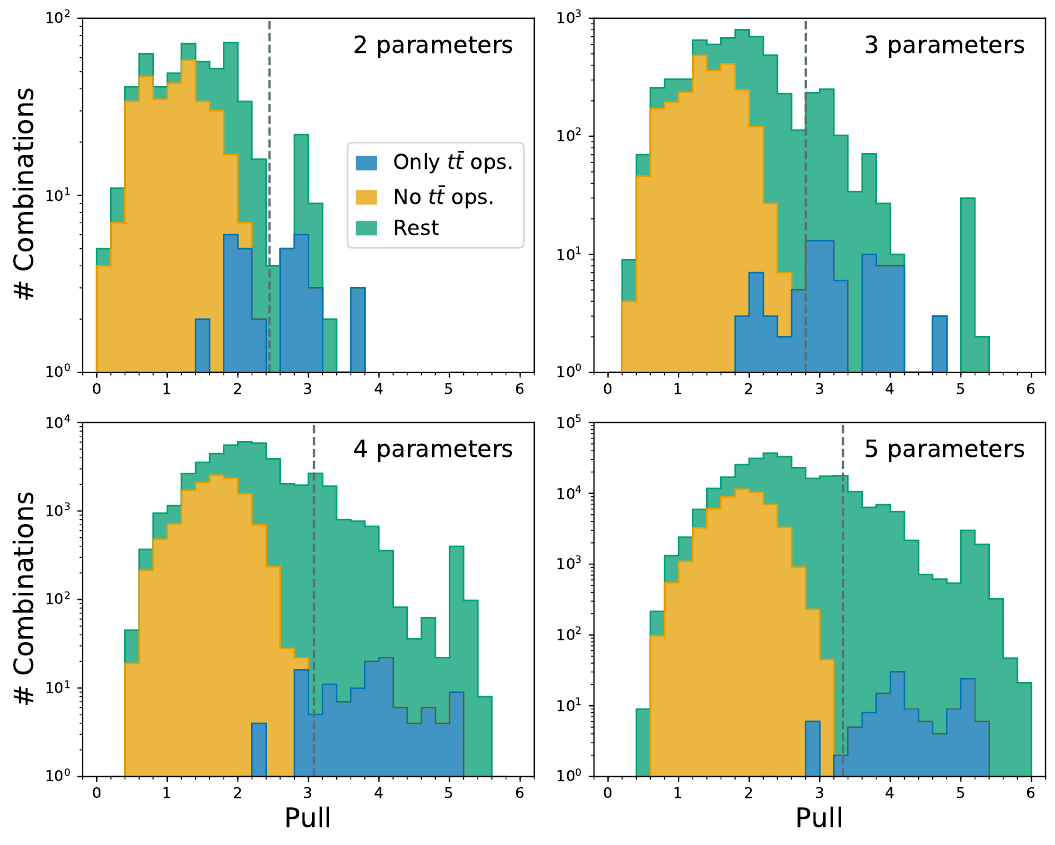
Figure 18 . Stacked histograms of the distribution of pulls obtained in fits to 2 (upper left), 3 (upper right), 4 (lower left) and 5 (lower right) parameter subsets. The subsets have been split into three categories: those that include only operators that affect t ¯ t production (blue), those that do not include operators that affect t ¯ t production (orange), and the rest (green). The dashed vertical lines mark the expected 95% ranges for the pull